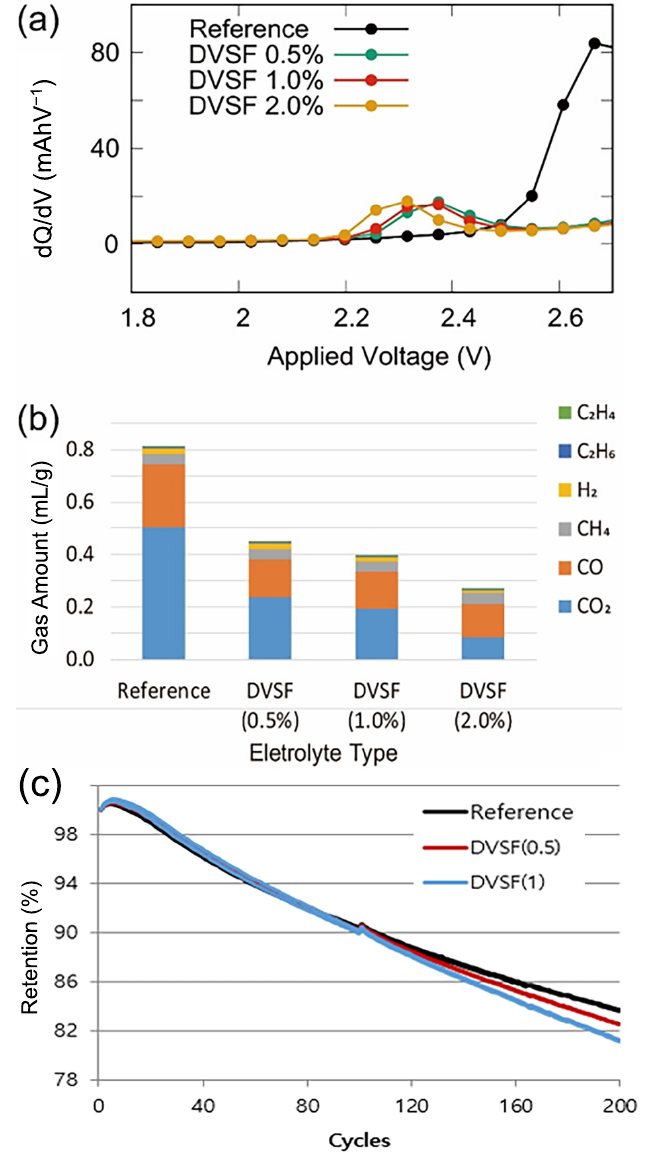
Figure 1. ( a ) Differential capacitance plot with respect to the applied voltage. The peak positions changed when the different amounts of DVSF were added to the reference electrolyte. ( b ) The amount of gaseous products measured with respect to the volume % of DVSF additives. ( c ) Capacity change over repeated charge-discharge (1C/1C) cycles. Up to the initial 90 cycles, the cell with 1% DVSF in the electrolyte had a slightly higher capacity than the reference cell. However, in the extended cycles, the battery cell with higher DVSF concentration had lower capacity than the reference battery cell. Note that the reference electrolyte was 1.15M of LiPF 6 solvated in the mixture of FEC, EC, DMC, and EMC with a 5:20:35:40 volume